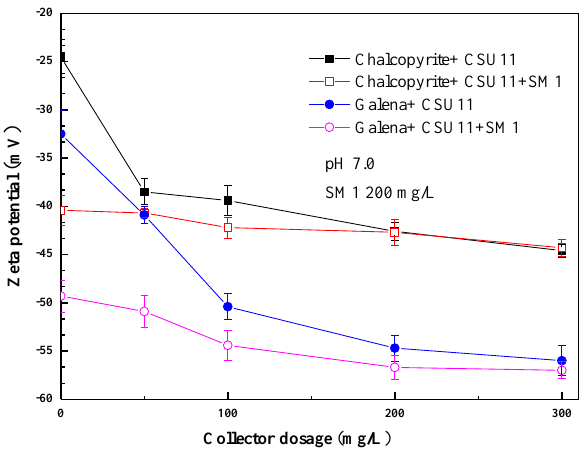
Minerals 2021 , 11 , 796 Figure 7. Effect of collector CSU11 concentration on the zeta potentials of mineral samples.